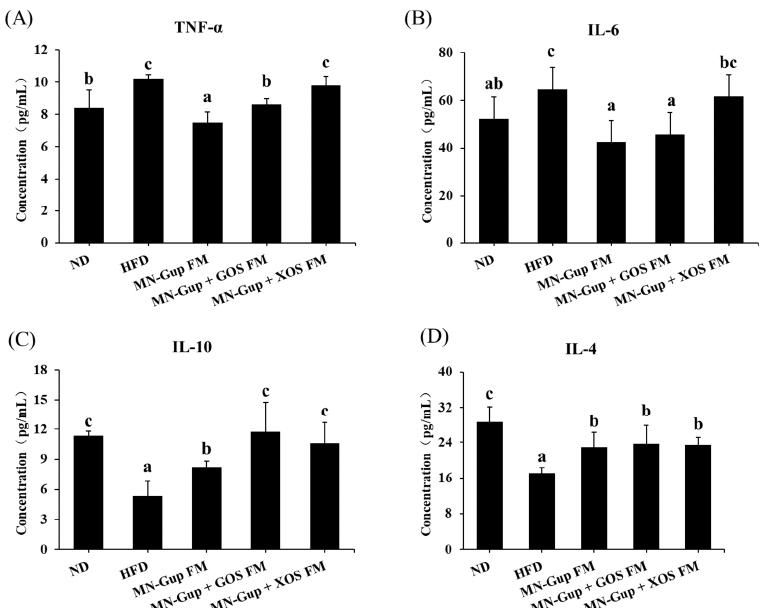
Figure 3. Effects of fermented milk containing MN-Gup or MN-Gup-based synbiotics on pro- inflammatory and anti-inflammatory cytokines in HFD-induced obese rats. The levels of ( A ) tumor necrosis factor α (TNF- α ), ( B ) interleukin 6 (IL-6), ( C ) IL-10, and ( D ) IL-4 in serum were measured. Different lowercase letters (e.g., a, b, c) indicate significant differences, p < 0.05, ( n = 5).